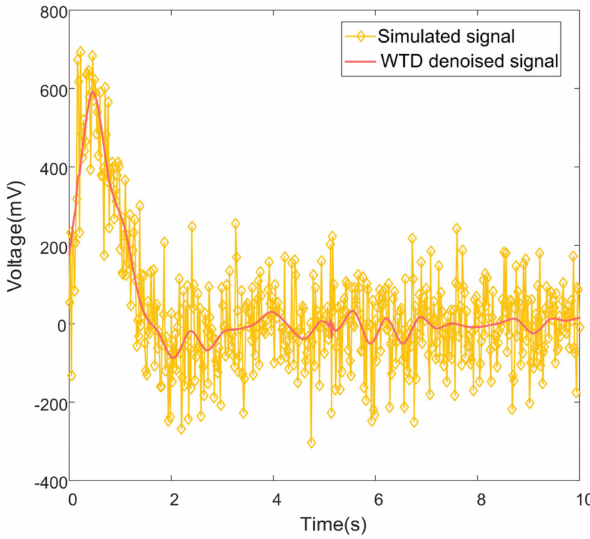
Figure 11. Simulated signal before and after wavelet threshold